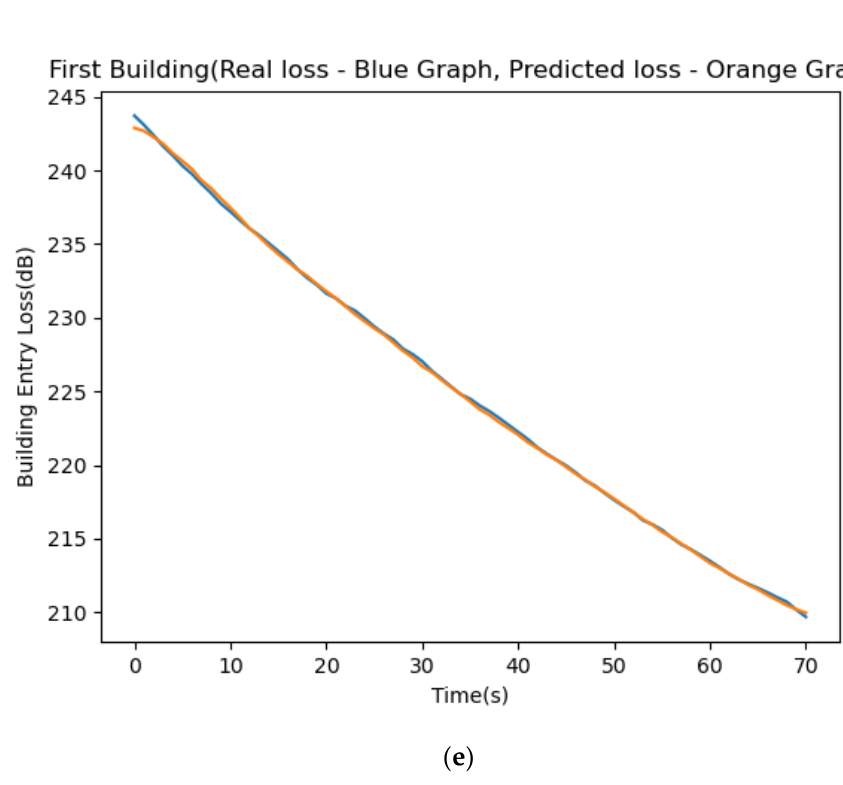
Figure 9. ( a ) Experiment results for 2.4 GHz; ( b ): Experiment results for 10 GHz; ( c ) Experiment results for 23 GHz; ( d ): Experiment results for 48 GHz; ( e ) Experiment results for 72 GHz.